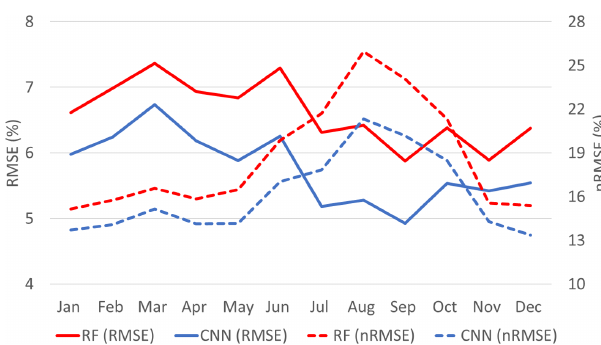
Figure 6. Monthly prediction accuracies with differences between two models for the entire period (2000–2017; RMSEs and nRM- SEs).